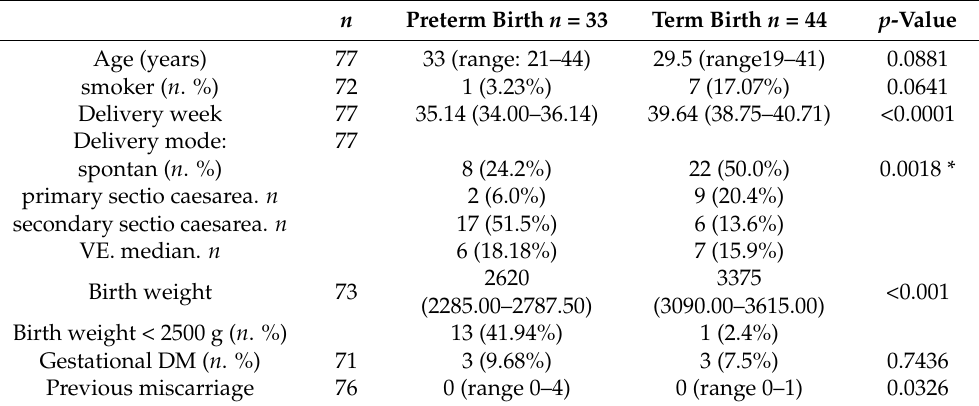
Figure 1. Study Flow chart. Table 1. Demographic and pregnancy outcome data: median with interquartile range